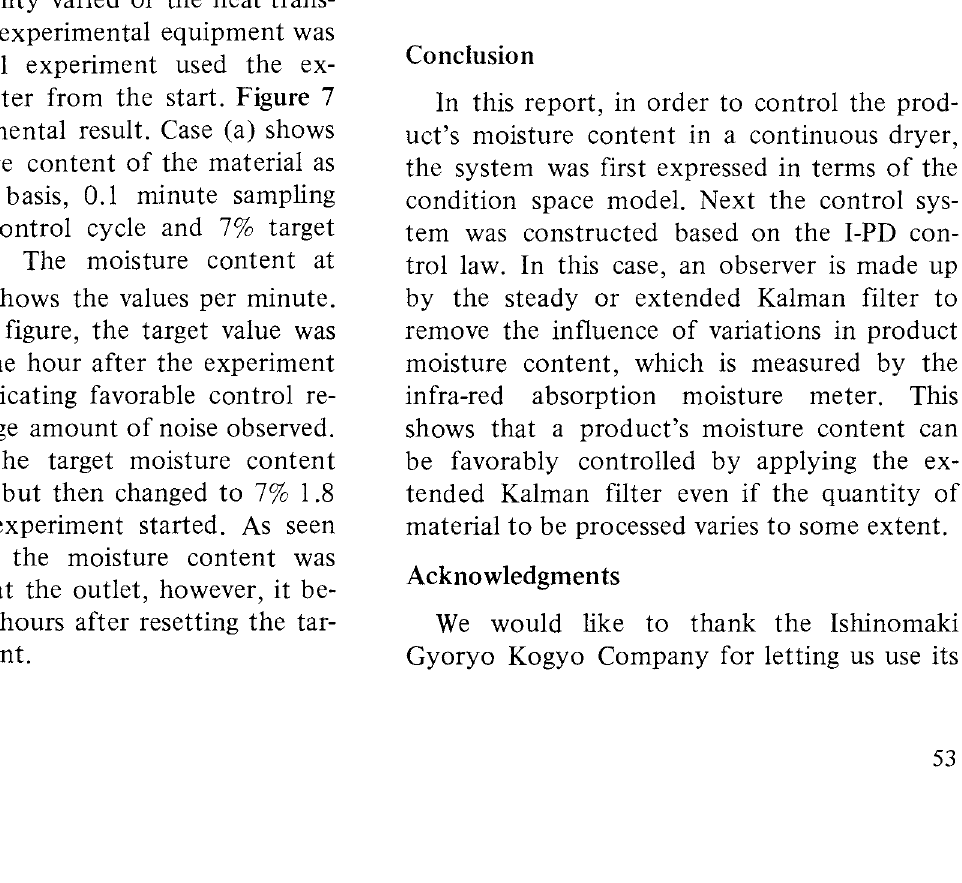
Fig. 7 Experimental result of controlled system (b) step change target moisture